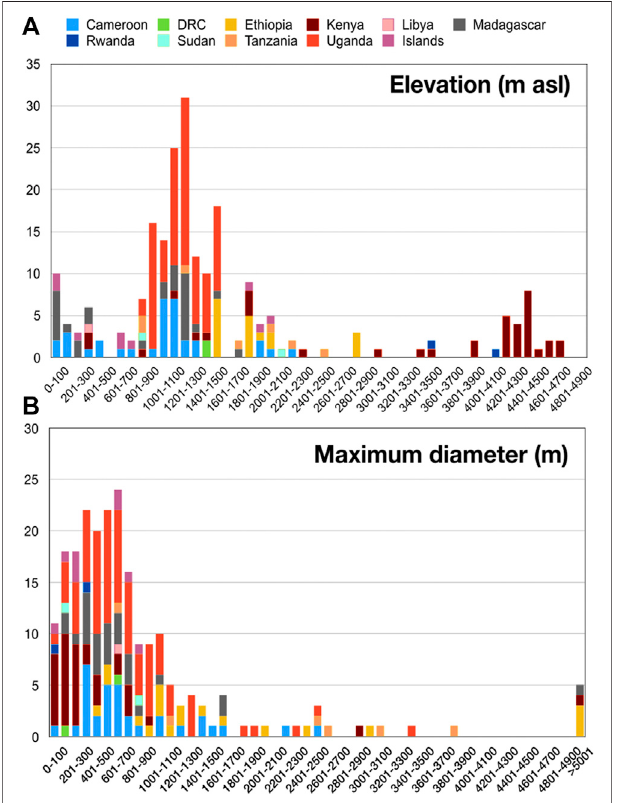
FIGURE 10 | Histograms of morphometric parameters (from Graettinger,2018)forthe220Africanvolcaniclakes: (A) AspectRatio(AR), (B) Elongation (EL), and (C) Isoperimetric circularity (IC).